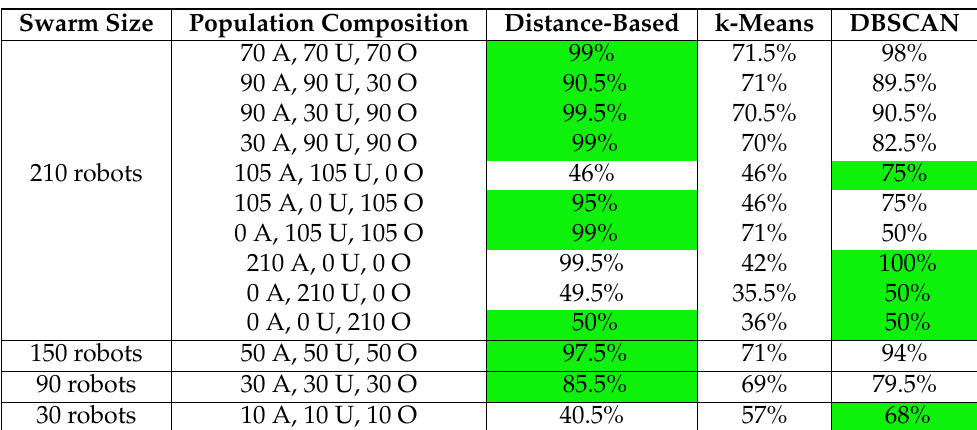
Table 2. The different swarm sizes and population configurations used to examine the classification accuracy of the three proposed